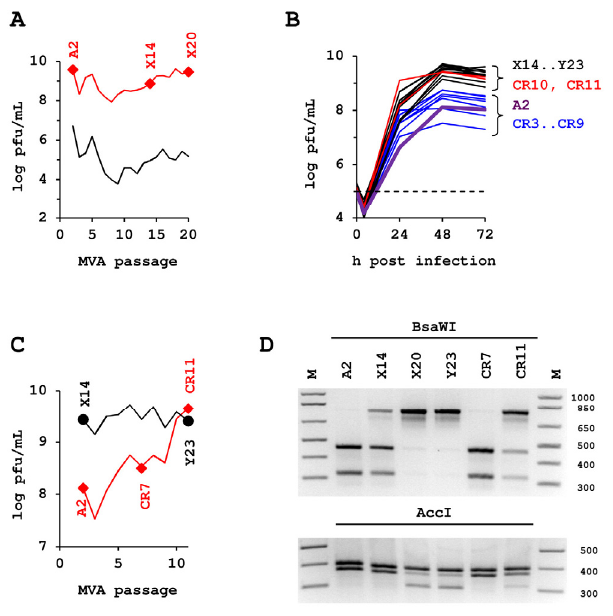
Figure 1. Effect of successive passages in CR suspension culture in chemically defined media and via induction of aggregates on yield and genotype of modified vaccinia Ankara (MVA). ( A ) to ( D ) The various lineages are marked with letters and the respective passage number is attached to the letter: MVA-A2 is the seed preparation, MVA-X3 to MVA-X20 describes the lineage of first passaging experiment, MVA-CR3 to MVA-CR19 the lineage of the second passaging experiment. ( A ) Passage of MVA with variable amount of input virus. The concentration of infectious units in the complete lysate used to inoculate the culture is shown in the lower curve (black line), the resulting yield in the upper curve (red line). Cell concentration was adjusted to 2 × 10 6 cells/mL at the time of infection for all passages. Yield of infectious units (usually 72 h post infection) was estimated from extent of CPE in the suspension culture. With this estimate infection for the next passage was performed. Actual MOI was determined retrospectively after titration of several passages in parallel and averages for the whole series at 0.096. ( B ) Serial passaging of MVA with precise MOI of 0.05 for each iteration. Shown is the superimposition of all time kinetics of high (>14) and low (starting with two) passages of MVA and concentration of input virus (stippled line). ( C ) Peak titers in the complete lysate in ( B ) usually were obtained 48 h post infection and are shown in this chart for the two parallel experiments for each virus passage. The passaging series that was started with the seed virus preparation MVA-A2 is shown in red, the reference passaging series that was started with the high passage isolate MVA-X14 from the experiment shown in ( A ) is depicted in black. ( D ) Accumulation of the D86Y genotype confirmed by restriction fragment length